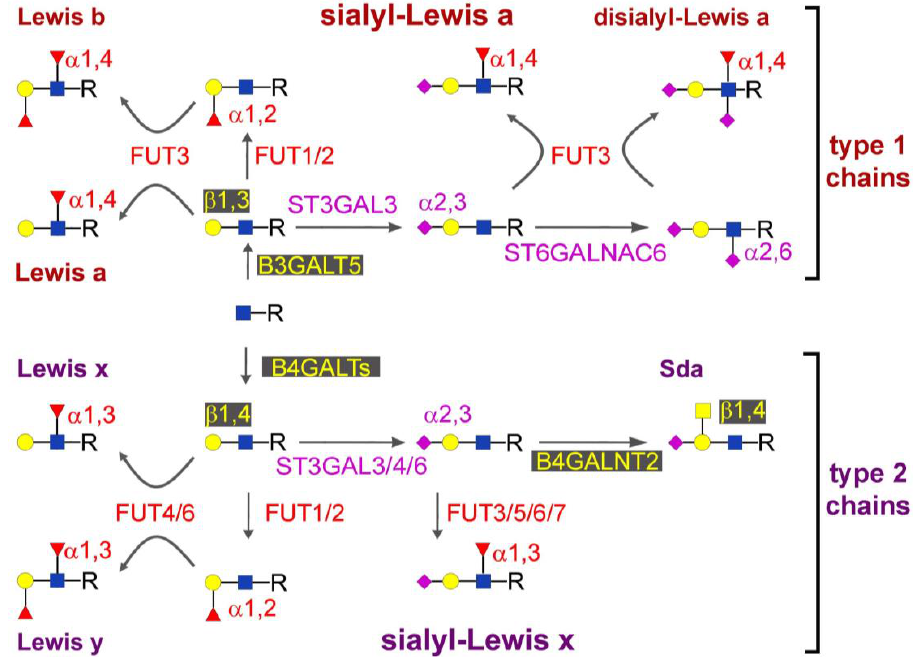
Figure 1. Structure and biosynthesis of Lewis antigens. Monosaccharides are depicted. Blue square: N-acetylglucosamine (GlcNAc); yellow square: N-acetylgalactosamine (GalNAc); yellow circle: galactose (Gal); red triangle: fucose (Fuc); pink diamond: sialic acid (Sia). Anomers, linkage positions, and enzymes involved in the reactions are indicated. All enzymes known to be able to perform a reaction are listed, note that only some of them are proven to be expressed in gastrointestinal tissues, as detailed in the text.